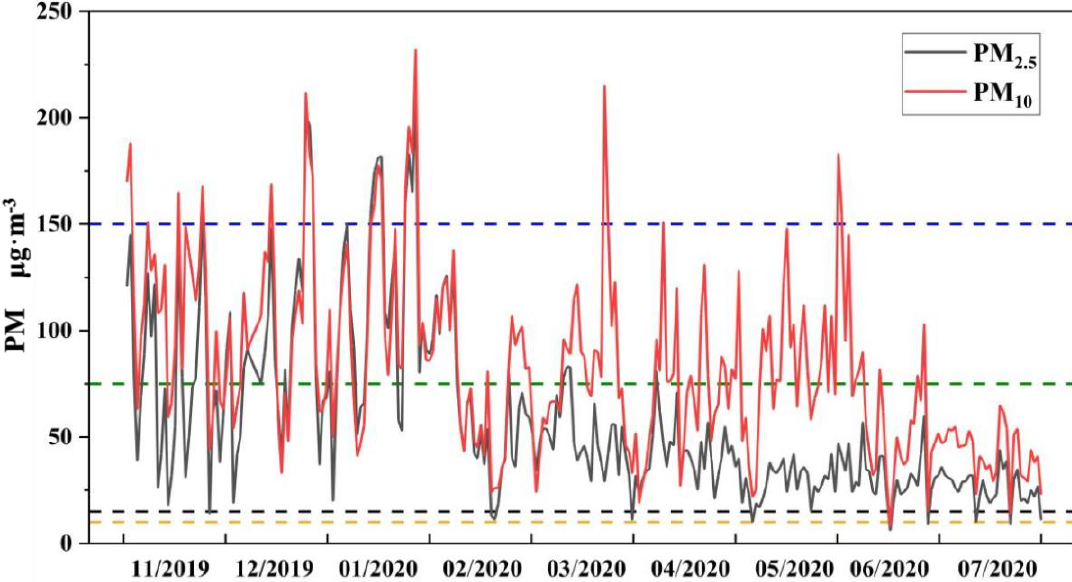
Figure 1. Daily average mass concentration of PM 2.5 and PM 10 in study area.